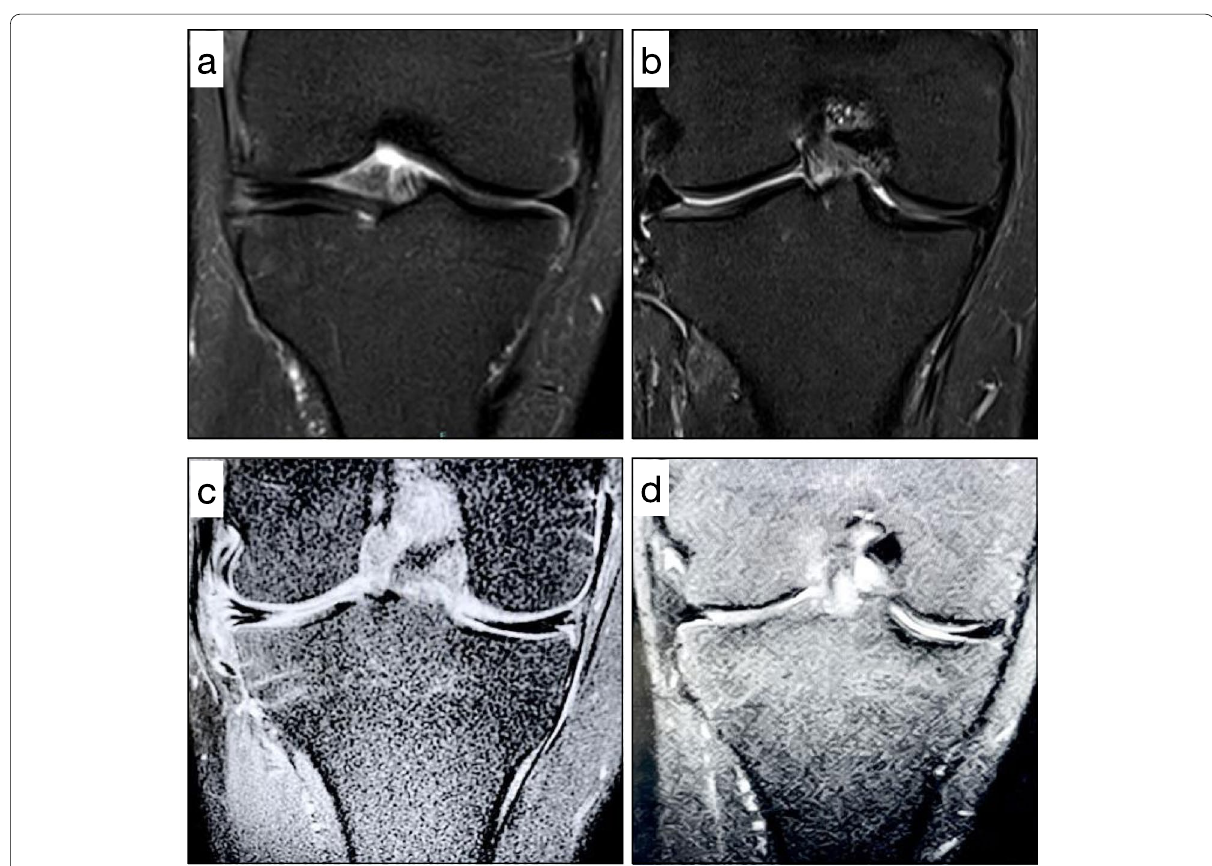
Fig. 5 a Coronal magnetic resonance of horizontal lesion of patient with lateral parameniscal cyst, b ) coronal magnetic resonance of the patient of a) after 36-month from surgery (partial meniscectomy and application of autologous PRP membrane; c ) and d ) coronal magnetic resonance of the same patient respectively at time of surgery and after 48 months from surgery. In both patient the meniscus appears healed with no recurrence of